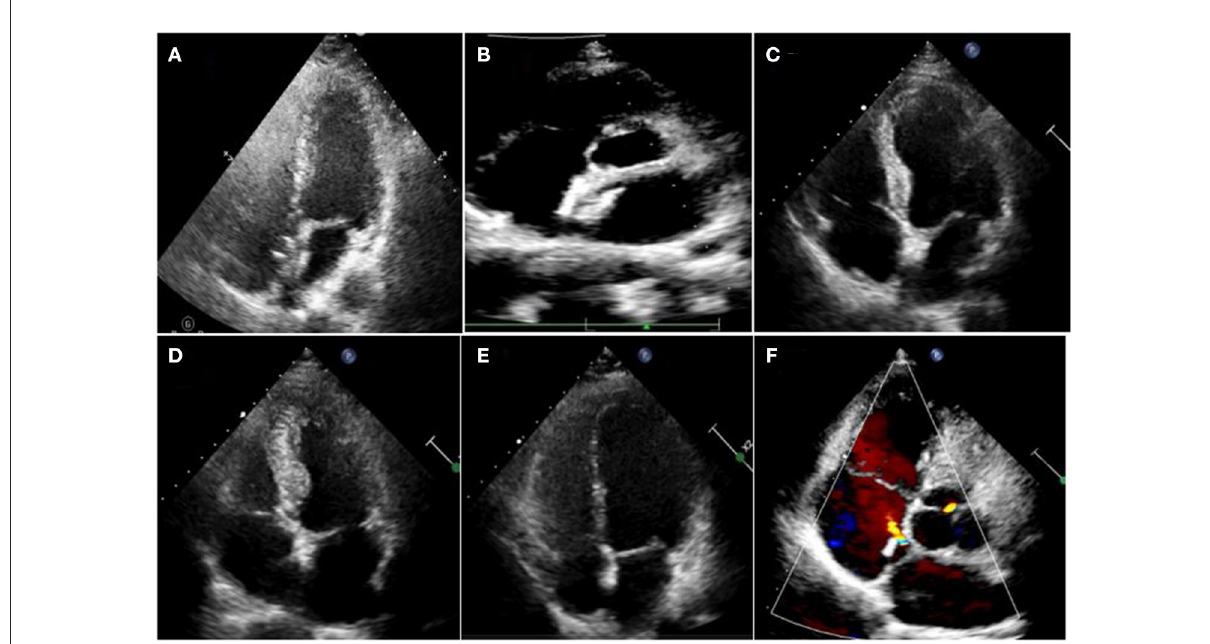
FIGURE3 Degradation process of the occluder at different time points after occlusion. (A) 2D-TTE displaying the morphology of the occluder at 2 days; (B) 2D-TTE displaying the morphology of the occluder at 1 month; (C) 2D-TTE displaying the morphology of the occluder at 3 months; (D) 2D-TTE displaying the morphology of the occluder at 6 months; (E) 2D-TTE displaying the morphology of the occluder at 12 months. (F) Color doppler TTE showing left-to-right shunting at the lower border of the occluder 12 months after occlusion.